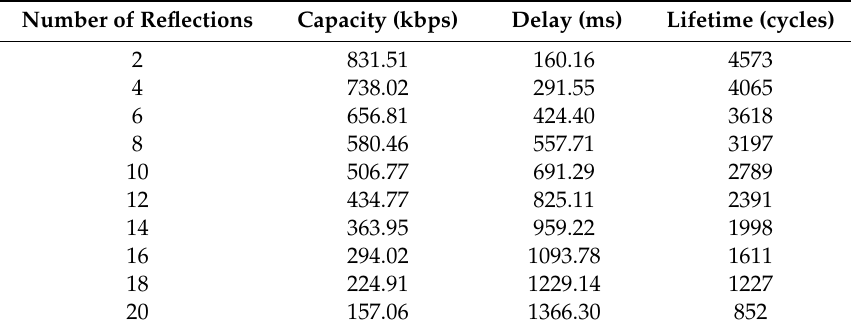
Table 4. Results of simulation for basalt material.